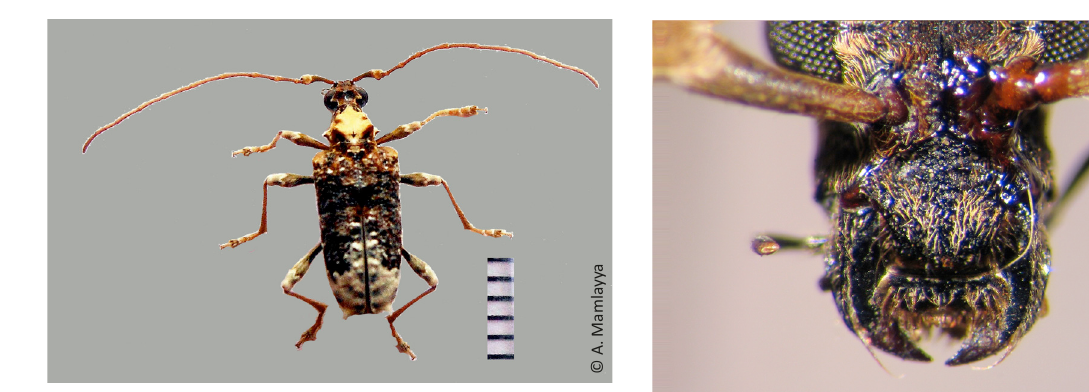
Image 1. Dorsal view of Apiocephalus licheneus . Note the typical shape and the pattern of elytral pubescence.